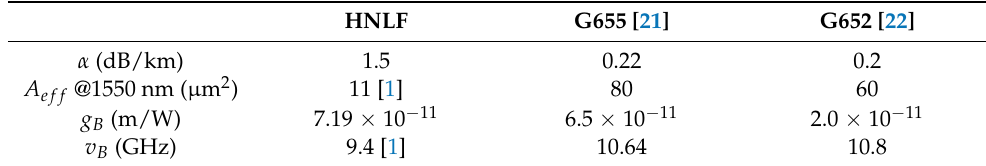
Table 1. Main parameters of three fibers.